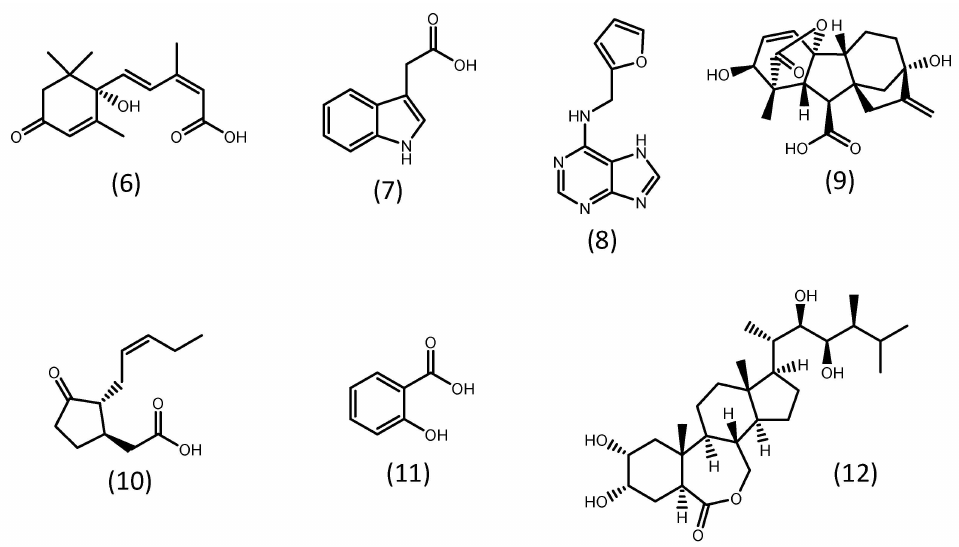
Figure 2. Examples of phytohormones. ( 6 ) abscisic acid; ( 7 ) indol-3-acetic acid (auxin); ( 8 ) kinetin (cytokinin); ( 9 ) gibberellic acid (gibberellin); ( 10 ) jasmonic acid (jasmonate); ( 11 ) salicylic acid; ( 12 ) brassinolide